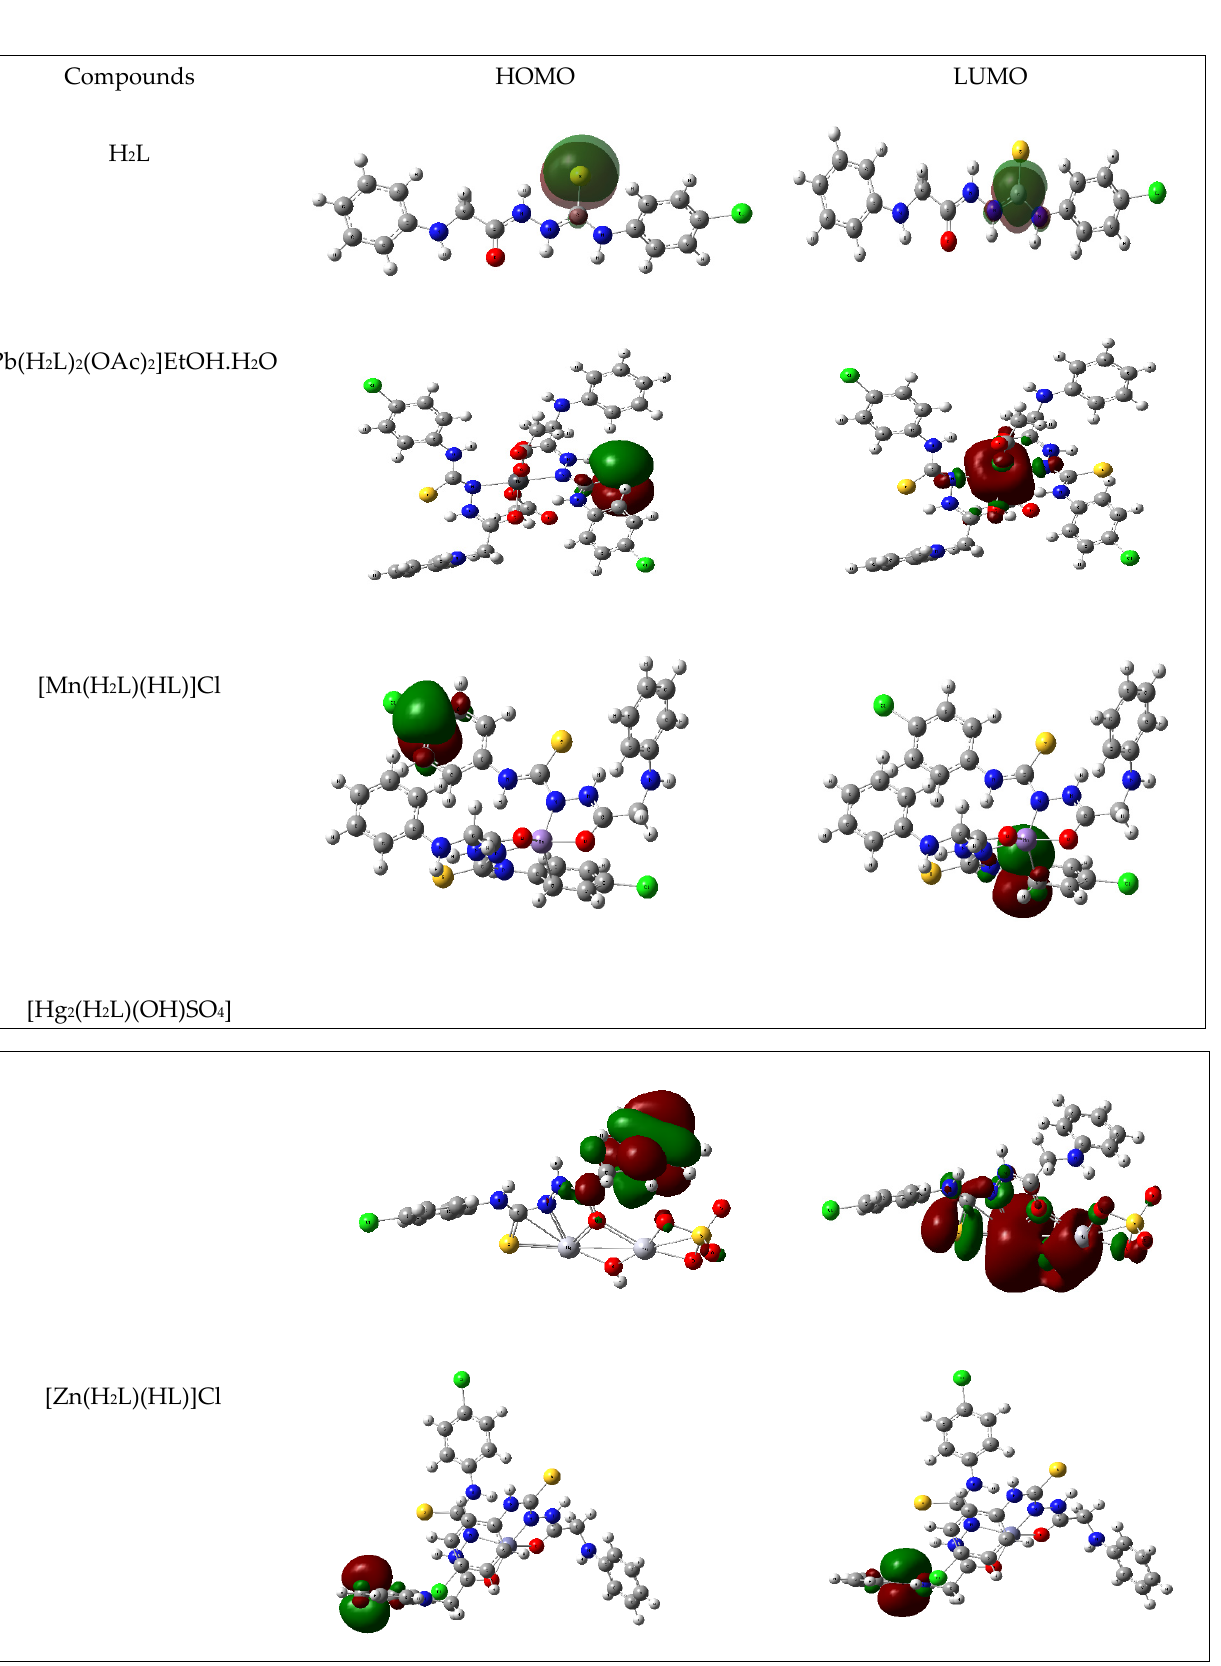
Figure 6. Frontier HOMO and LUMO molecular orbitals for the ligand H 2 L and Pb(II), Mn(II), Hg(II), and Zn(II) complexes, calculated at DFT level.